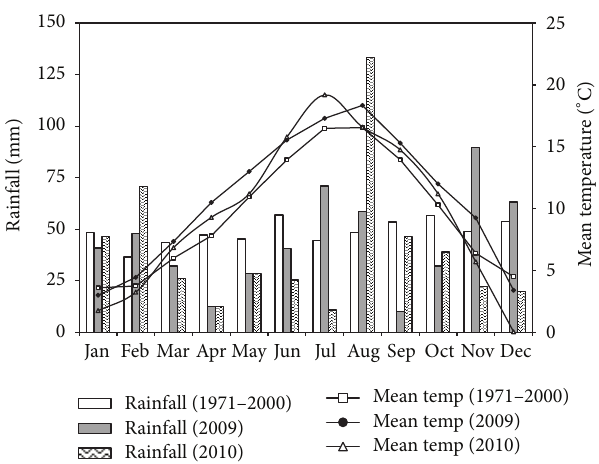
Figure 1: Rainfall and temperature records for Silsoe, Bedfordshire, UK